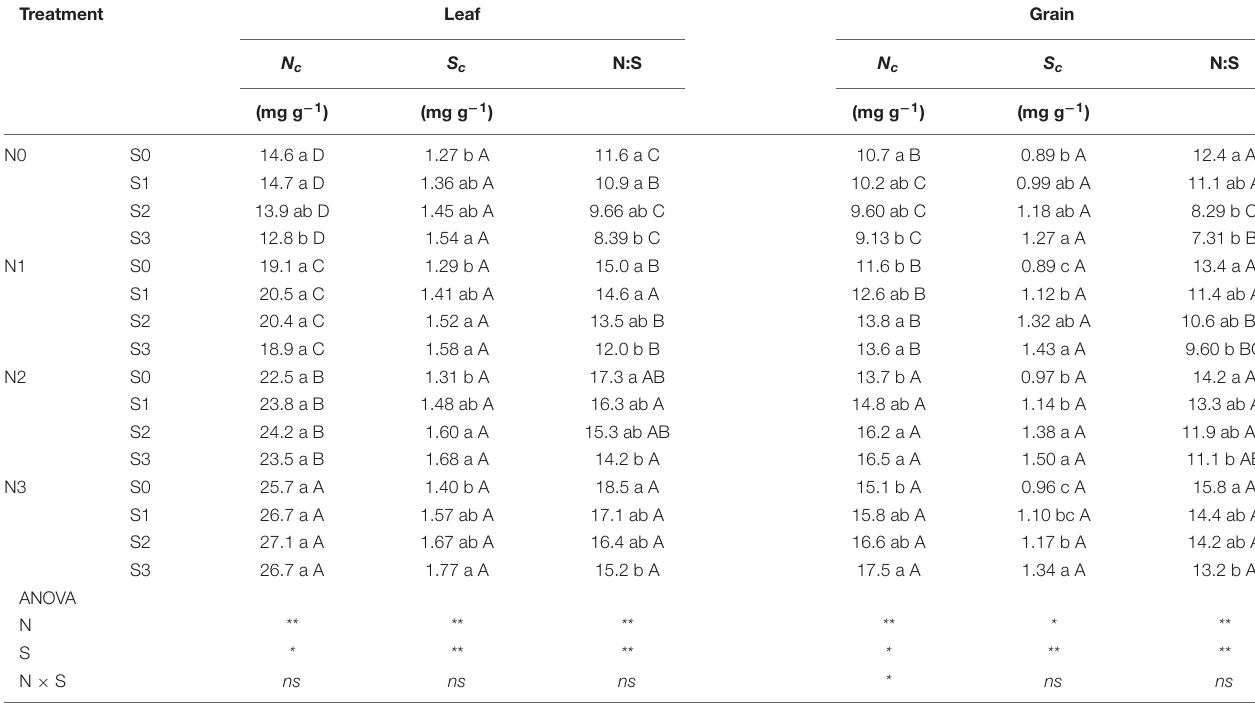
The data are the means of four replicates (N = 4). Different lowercase letters after the data indicate the significant differences between the different S rates at the same N level (P < 0.05), and different capital letters after the data indicate the significant differences between the different N rates at the same S level (P < 0.05). The